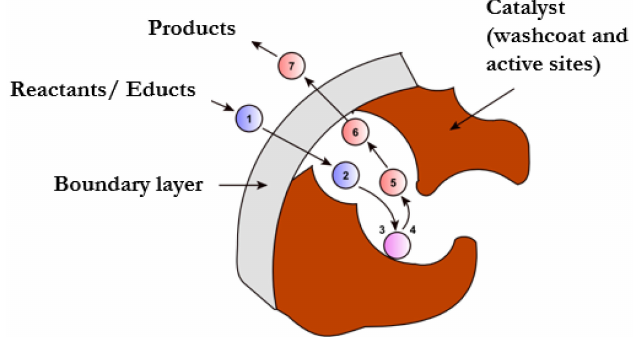
Figure 17. Characteristic phases of heterogeneous catalysis [66] (translated into English). Copyright 2010, Use under the terms of the GNU Free Documentation License, Version 1.2, Roland Mattern, CC BY 3.0 https://creativecommons.org/licenses/by/3.0 (accessed on 25 November 2022)